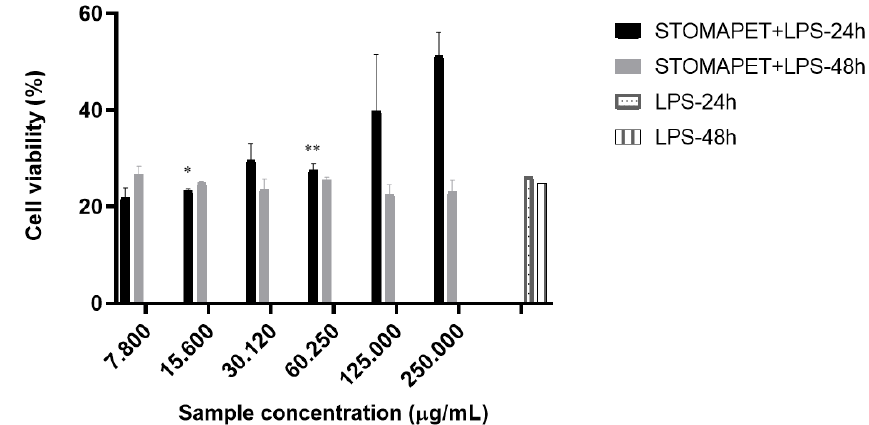
Figure 5. The e ff ect of STOMAPET on LPS-stimulated SC cells exposed for 24 and 48h (MTS assay). Figure 5. The effect of STOMAPET on LPS-stimulated SC cells exposed for 24 and 48 h (MTS assay). Values represent mean ± SD (n = 3, * p < 0.05, ** p < 0.01, *** p < Values represent mean ± SD (n = 3, * p < 0.05, ** p < 0.01, *** p < 0.001).